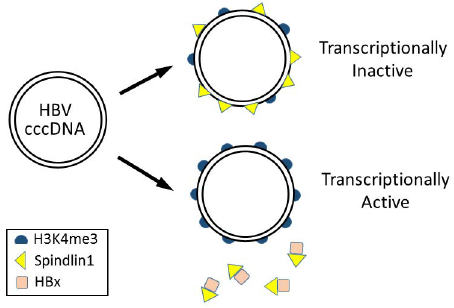
Figure 1. Model for epigenetic regulation of HBV gene expression by Spindlin1. HBV cccDNA in the nucleus is associated with nucleosomes, which may be modified by trimethylation at lysine 4 of histone H3 (H3K4me3). Spindlin1 binds the HBV cccDNA to reduce the H3K4me3 level, resulting in the suppression of HBV gene expression. In the presence of HBx, Spindlin1